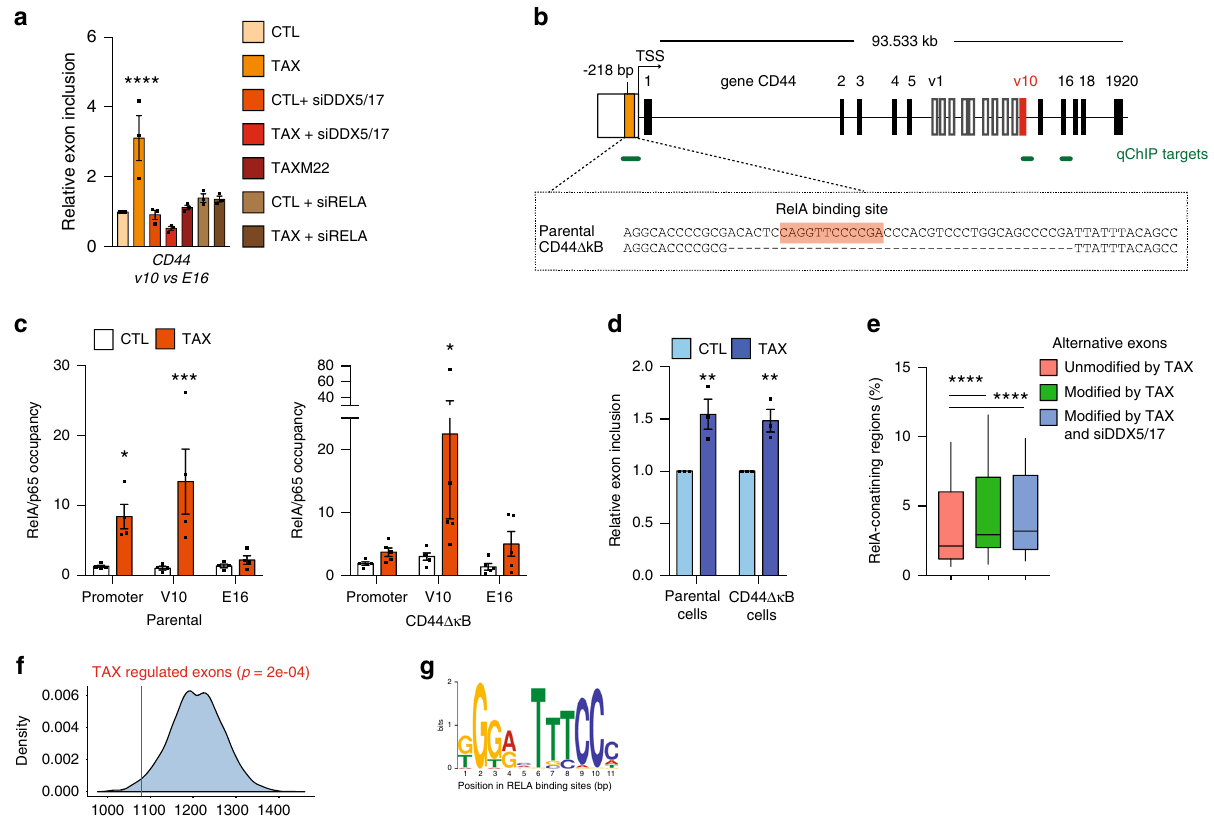
Fig. 4 Intragenic RELA-binding sites associate with alternative splicing events. a Alternative splicing modi fi cations of the CD44 exon v10 upon in HEK cells expressing or not Tax and knocked down or not for RELA or DDX5/17 expressions. TaxM22 and siRNA-mediated RELA depletion were used to assess the dependency of splicing events after NF- κ B activation. Histograms represent the results of exon-speci fi c quantitative RT-PCR measurements computed as a relative exon inclusion (alternatively spliced exon vs constitutive exon re fl ecting the total gene expression level). b Schematic representation of the human CD44 gene. Black and white boxes represent constitutive and alternative exons, respectively, as previously annotated (50). The orange box represents the kB site localized at – 218 bp from the TSS and the 40 bp fragment deleted by CRISPR/Cas9 in CD44 Δ kB HEK cells. c qChIP analysis of RELA occupancy across the promoter, the exon v10, and the constitutive exon E16 of CD44. RELA enrichment is expressed as the fold-increase in signal relative to the background signal obtained using a control IgG. d Relative exon inclusion of CD44 exon v10 was quanti fi ed by qRT-PCR in parental cells and its CD44 Δ kB counterparts. e Distribution of alternative exons that are regulated or not by Tax and DDX5/17 in RELA-enriched intragenic regions. The analysis was restricted to alternative exons expressed in HEK cells and regulated or not by Tax. Boxes extend from the 25th to 75th percentiles, the mid line represents the median and the whiskers indicate the maximum and the minimum values. f Bootstrapped distribution of median distance between intragenic RELA peaks and either Tax-regulated exons (red line, 1079 bp) or randomly chosen exons (10 5 repetitions) (blue). p -values were determined by sample t - test. g Consensus de novo motif for RELA-binding sites <1 kb of Tax-regulated exons. Data are presented as the mean ± SEM values from biological replicates. Each black square represents a biological replicate. Statistical signi fi cance was determined with two-way ANOVA followed by Fisher ’ s LSD test (* p < 0.05, ** p < 0.01, *** p < 0.001) ( a , c , and d ) and two-tailed Wilcoxon test ( e , **** p < 0.0001). Exact p -values for Tax vs CTL: a <0.0001, c